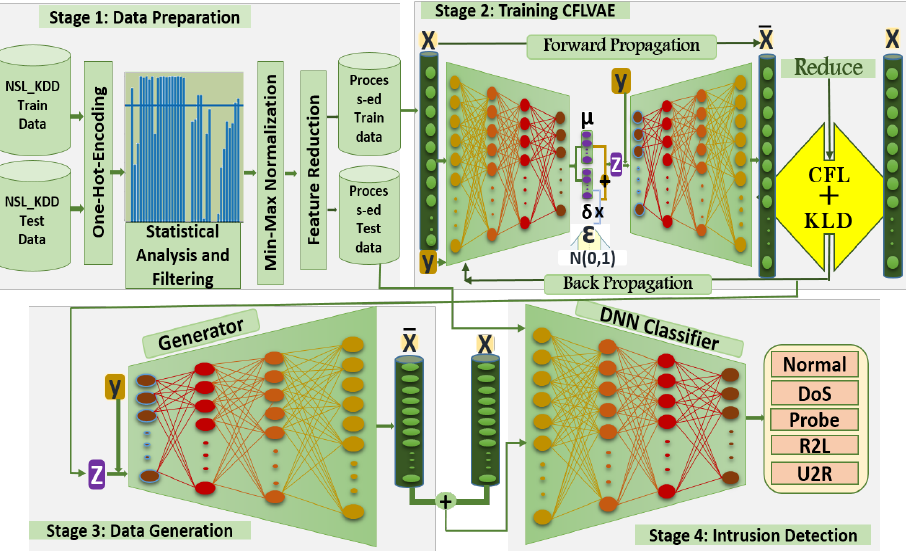
Figure 3. Proposed CFLVAE-DNN